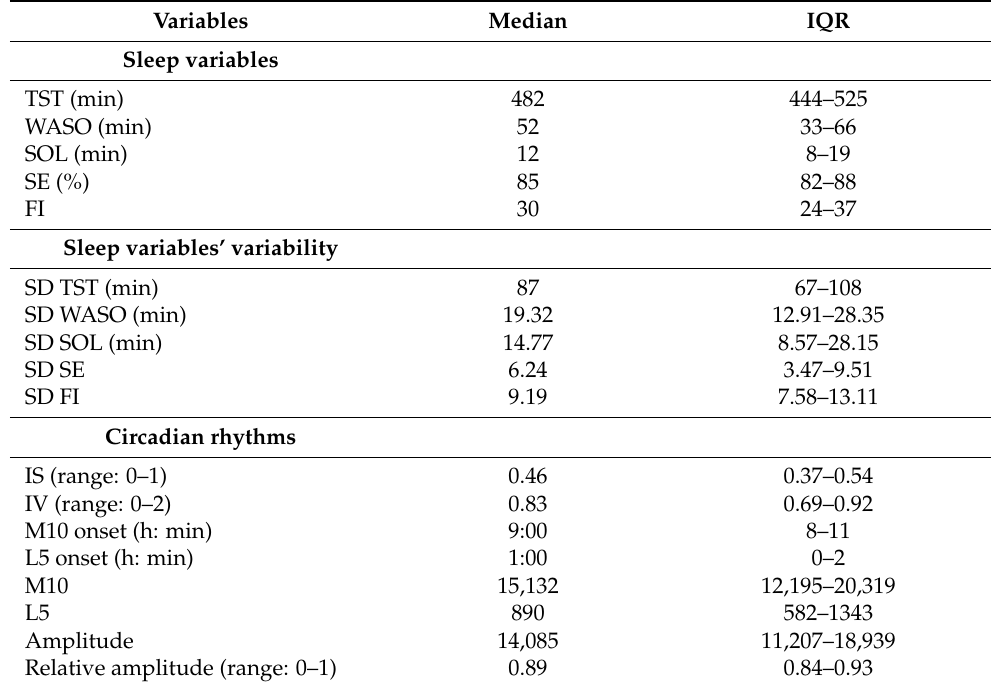
Table 2. Sleep and circadian rhythms characteristics of the